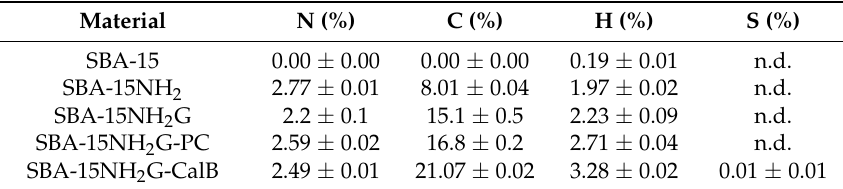
Table 3. Elemental analysis of synthesized mesoporous materials.